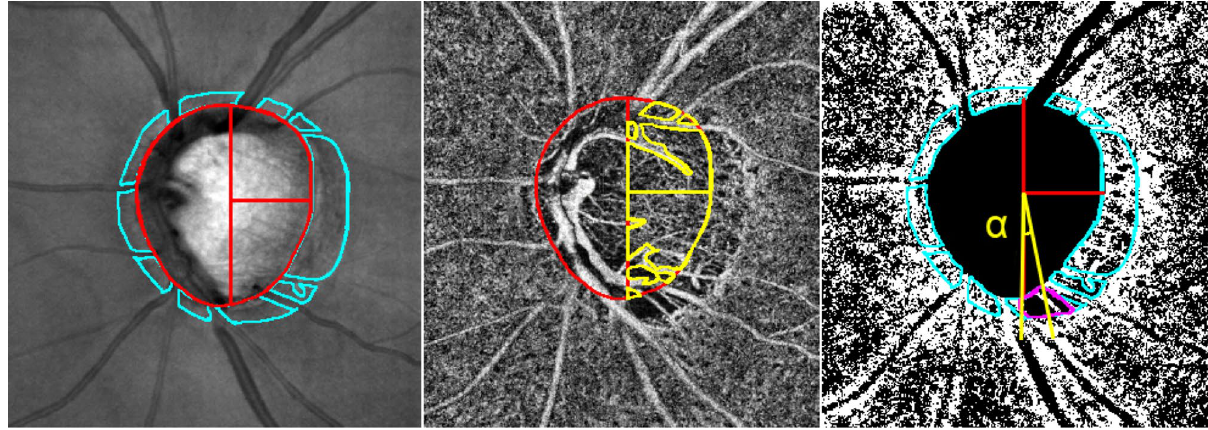
Figure 2. Measurements of optic nerve head vessel density (ONH-VD) and parapapillary choroidal vessel density (pCVD) and angular extent of choroidal microvasculature dropout (CMvD) in open-angle glaucoma (OAG) eye with CMvD using optical coherence tomography angiography (OCT-A). (Left) The red ellipse indicates the optic nerve head (ONH) margin, while the red lines denote the boundaries of ONH-VD measurement areas within the ONH. The sky blue outline indicates the β-parapapillary atrophy (β-PPA) margins, excluding large retinal vessels, identified on a scanning laser ophthalmoscopy (SLO) image, which are applied to same position within the β-PPA on the OCT-A choroidal layer en-face image. (Middle) The region of interest (ROI) within the ONH, excluding large retinal vessels, were manually demarcated (yellow outline). These area of interest were used to measure the global ONH-VD using ImageJ software. Superotemporal and inferotemporal ONH area divided by horizontal line were used for superior and inferior ONH-VD measurement, respectively. (Right) The selected area of interest, excluding large retinal vessels, within the β-PPA was converted to ROI, then applied to the 8- bit binary slab of OCT-A choroidal layer en-face image. The CMvD area is enclosed by the purple-colored border. The two points at which the circumferential border of the CMvD met the ONH margin were identified as the circumferential margins. The two yellow lines connect the ONH center to the circumferential margins of the CMvD. Angle α is the angular extent (degrees) of the CMvD. All OCT-A images were created by Avanti system version